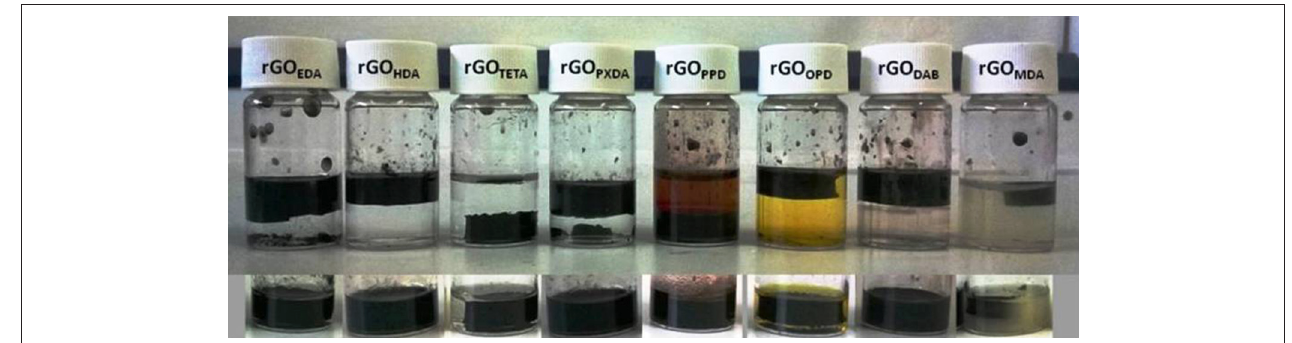
FIGURE 1 | Hydrogels as prepared by hydrothermal treatment (lower) , and after the addition of water (upper)